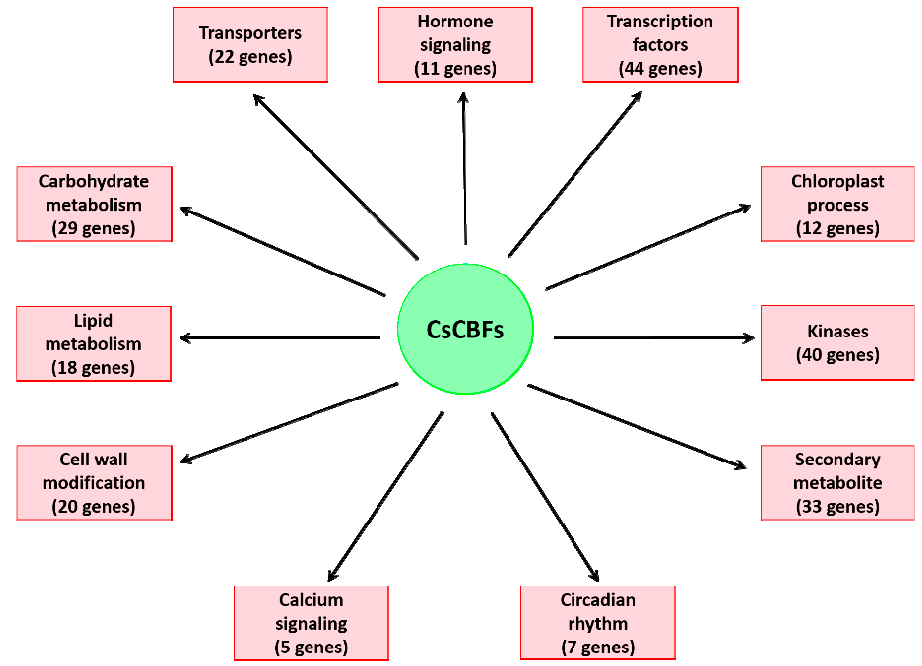
Figure 6. Functional categories of putative CsCBF target genes. The target genes were divided into 11 categories according to their biological functions. Their expression values and annotations are listed in Table S5.